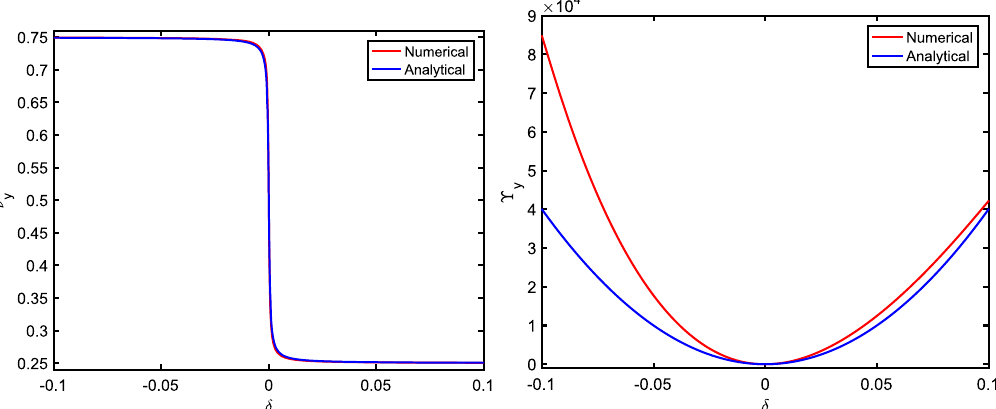
FIG. 6. (Left) The vertical phase advance in unit of 2 π , namely ν y ¼ ψ y = 2 π and (right) the Sands ’ mismatch parameter ϒ as a function of δ